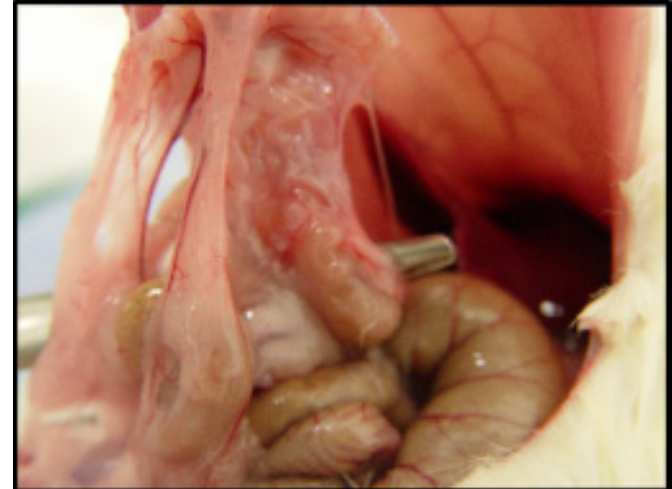
FIGURE 3 - Rat from group 3 with adhesions to the polypropylene mesh/